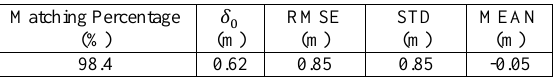
Table 1. Accuracy statistics of RSP on the Terrassa dataset